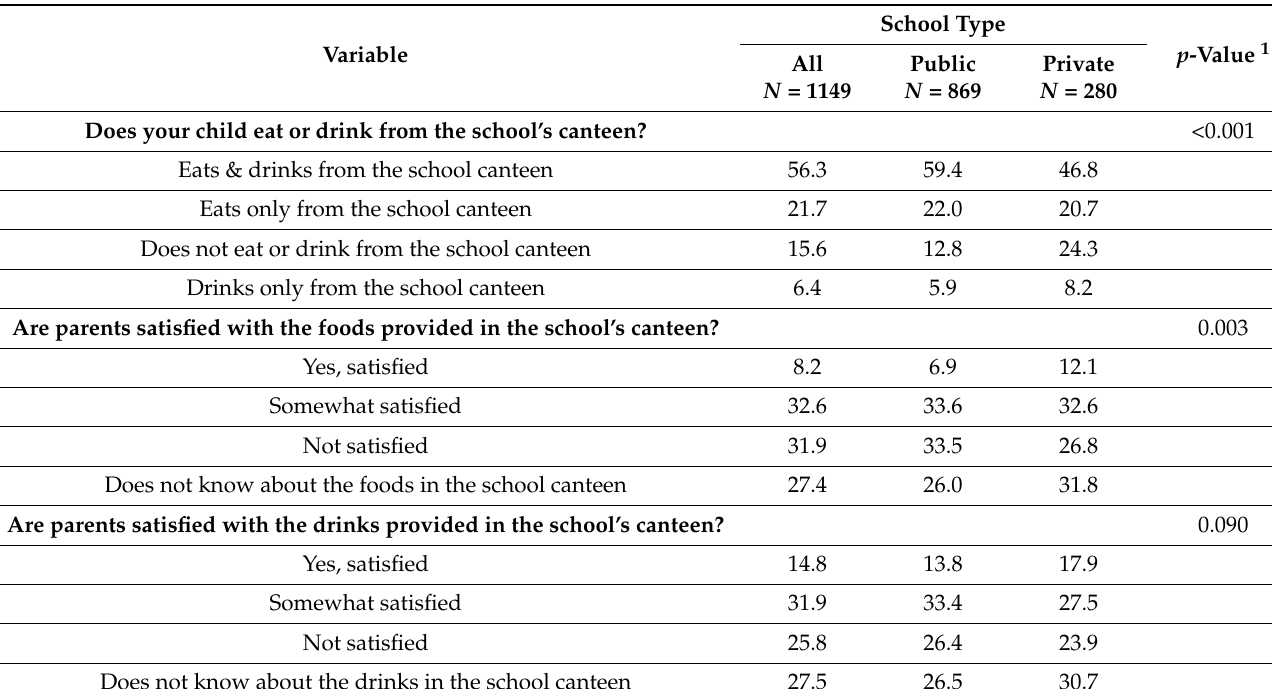
Table 4. Parent responses related to school canteen by school type.